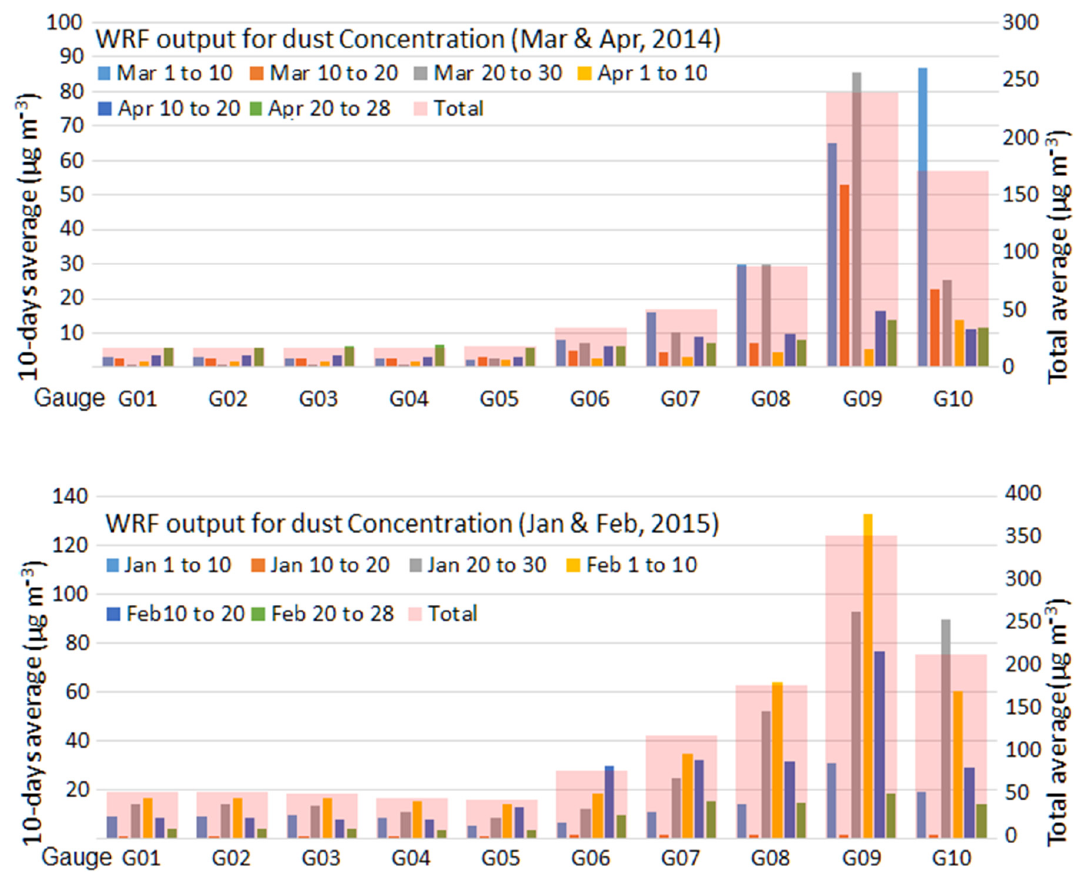
Figure 13. Time series of the 10-day average and the total average modeled concentration (µg m − 3 ).